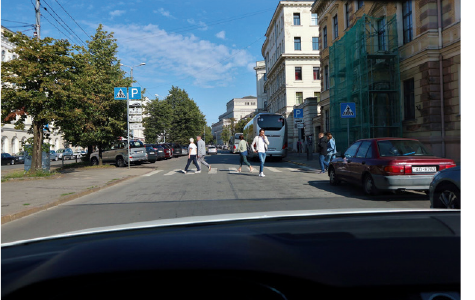
Figure 2a. Driver’s view during daytime Figure 2b. Driver’s view at